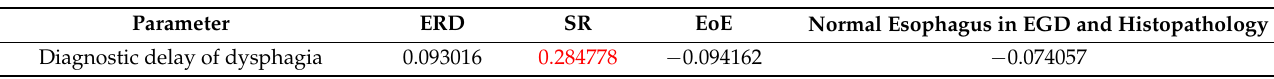
Table 4. Spearman’s rank correlation coefficients between diagnosis of ERD, SR, EoE, normal esophagus in EGD and histopathology examination and diagnostic delay of dysphagia. Statistically significant—in red.